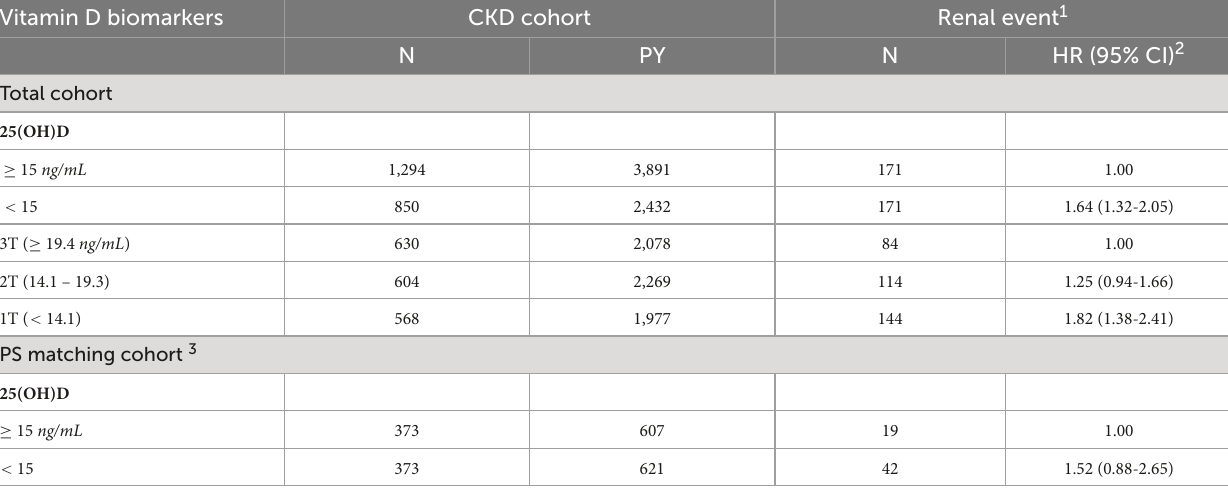
TABLE 2 Association between serum vitamin D levels and renal event in the Korean Cohort Study for Outcome in Patients With Chronic Kidney Disease (KNOW-CKD) study, 2011-2015. Vitamin D biomarkers CKD cohort Renal event 1